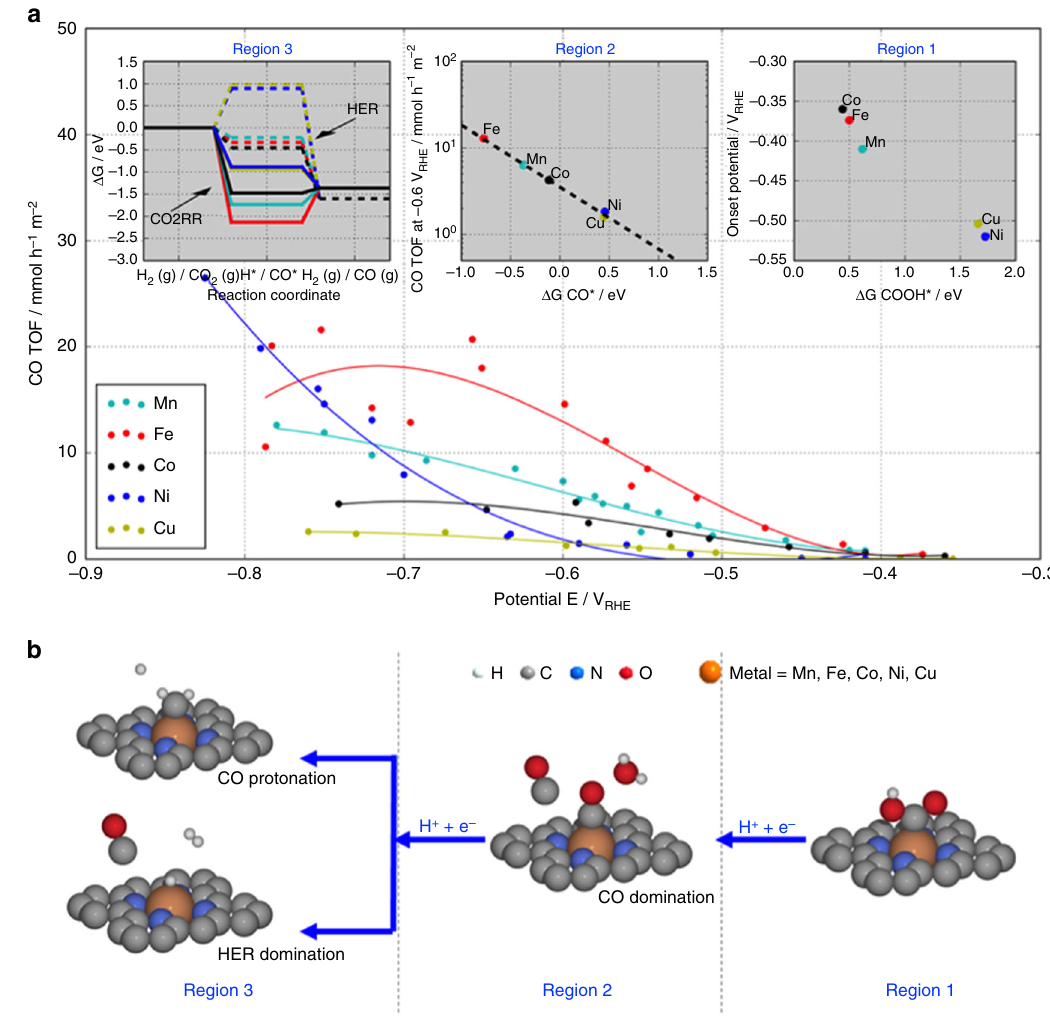
Fig. 5 Experimental correlation to simulations. Experimental CO production turnover frequency (TOF) of the M – N – C catalysts vs. applied IR-corrected electrode potential (see Supplementary Equation 4). The catalytic reactivity trends a and reaction pathway b split into 3 potential regions with distinctly different rate-determining mechanistic features. Insets: Region 1: Low overpotentials, the experimental onset potentials of CO production (better seen on the log (CO TOF) — E plot in Supplementary Fig. 15) correlate with the binding energy of the reaction intermediate COOH* taken from Supplementary Fig. 14. Region 2: Intermediate over-potentials, CO production TOF at − 0.6 V RHE correlates with the free energy of adsorbed CO, CO* taken from Supplementary Fig. 14; Region 3: High overpotentials, free energy diagrams for the HER (dashed paths) and CO2RR (solid paths) at − 0.8 V RHE for each M – N – C catalyst. HER barriers are high for Ni and Cu, while CO2RR is downhill making these materials favorable CO producing